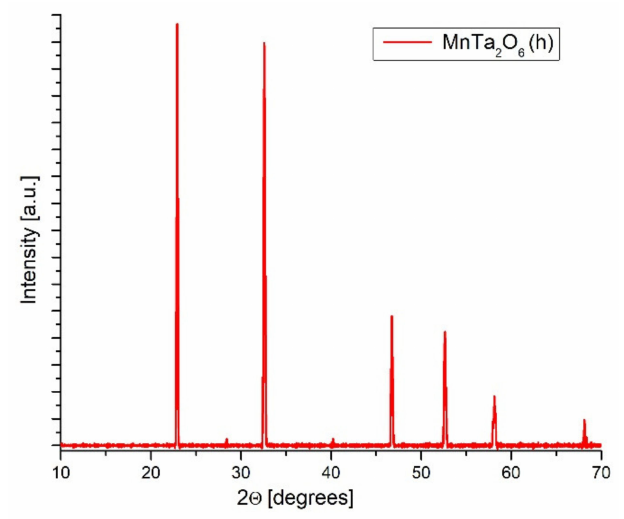
Figure 2. XRD patterns of MnTa 2 O 6